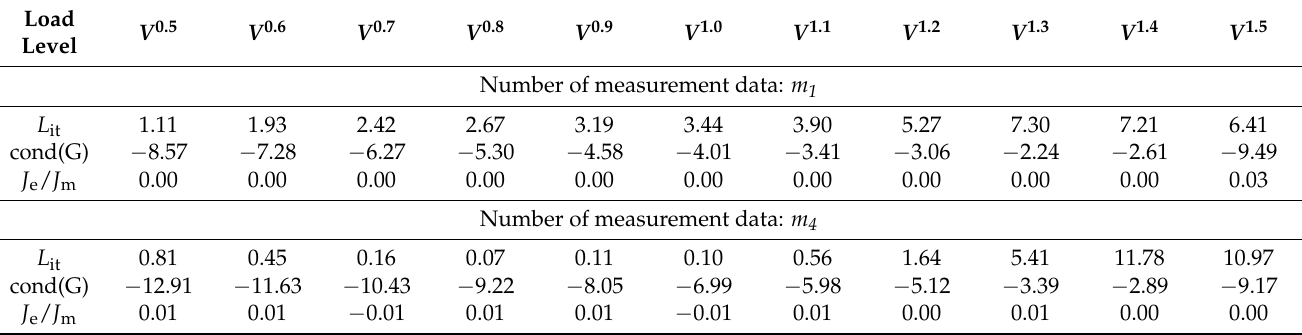
Table 9. The relative differences of mean values of the considered indices for Method 2 in the rectangular and polar coordinate system in